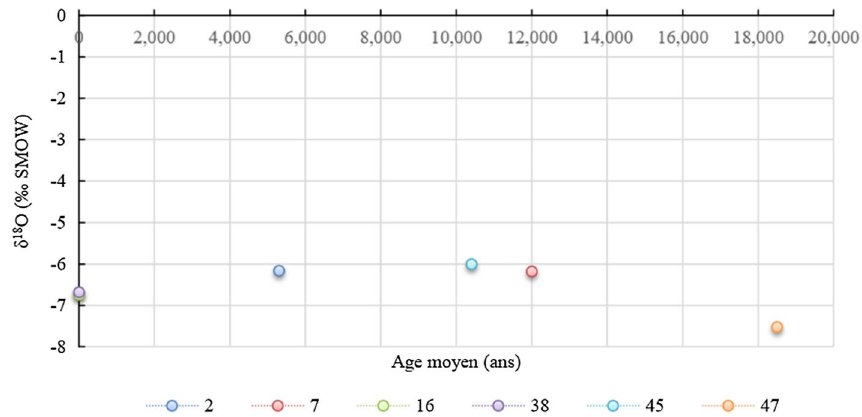
Fig. 6 Relation age -δ 18 O